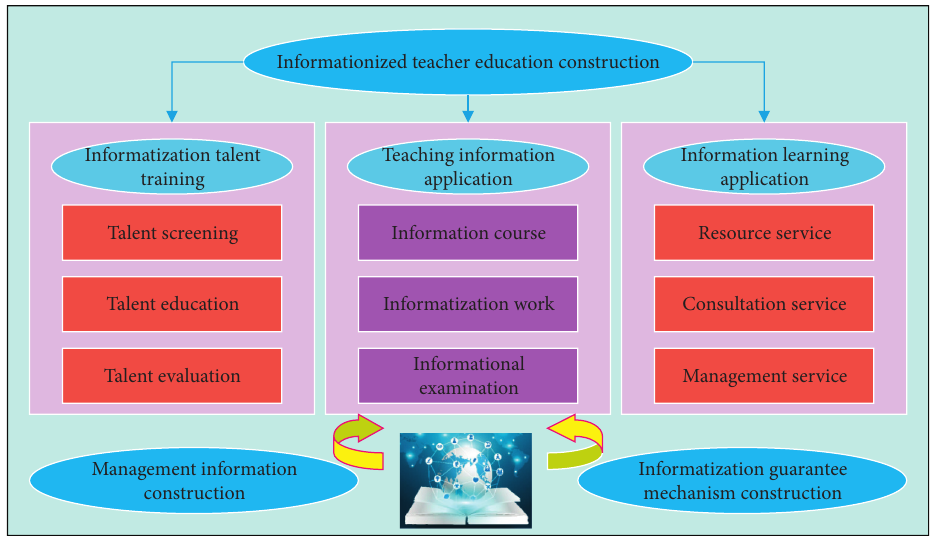
Figure 1: The basic structure diagram of the content of education informatization construction.